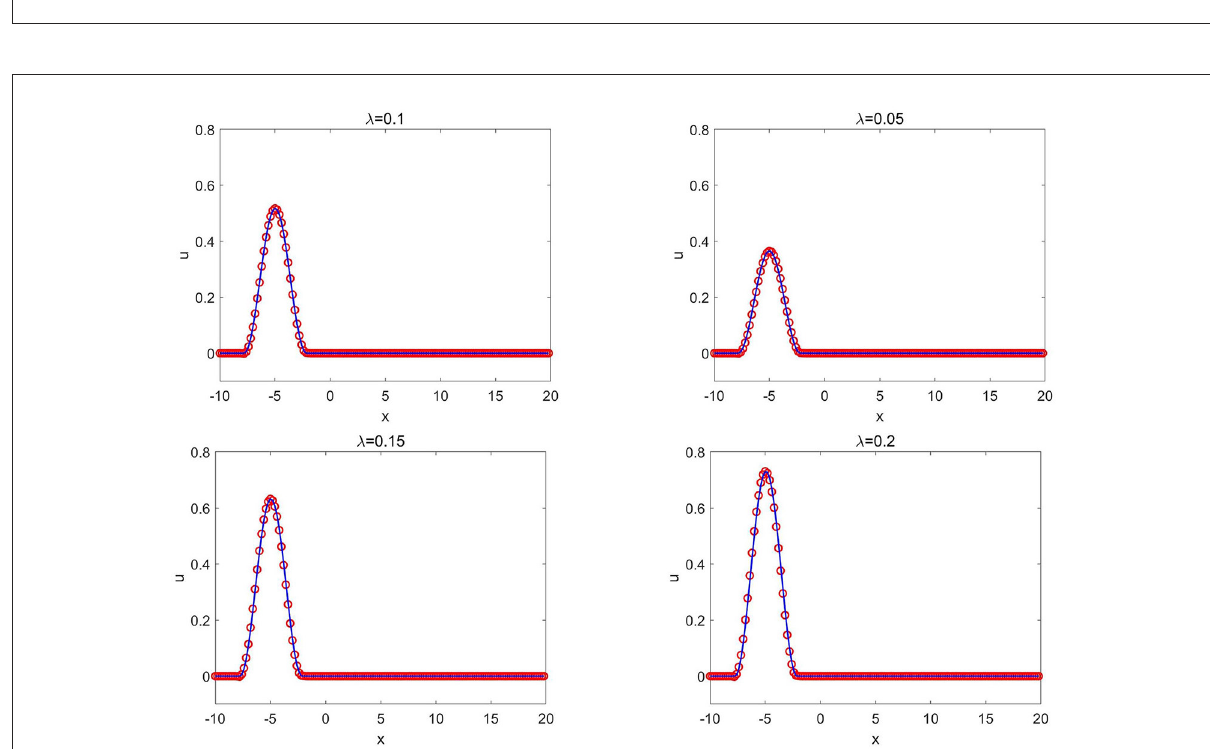
FIGURE13 Generalized fifth order KdV equation of Example 3.8: the CANN solution (red circles) and the exact solution (solid blue lines) at T different values of λ where x 0